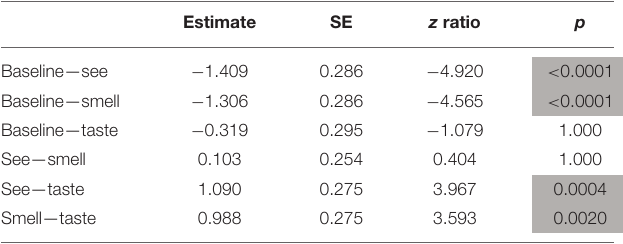
TABLE 5C | Both (character and narrator’s) opinion responses: pairwise comparisons for Experiment